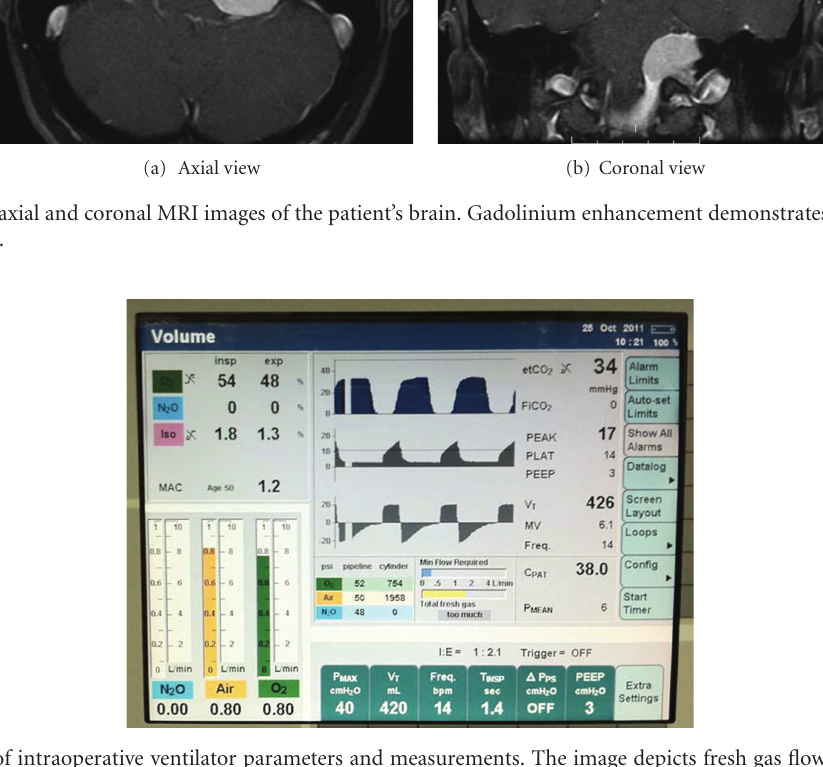
Figure 2: Screen shot of intraoperative ventilator parameters and measurements. The image depicts fresh gas flows, expired and inspired concentrations of isoflurane, airway pressures and flows, and expired CO 2 tracings. Tidal volume was set at approximately 6mL/kg. The anesthesia machine was an Apollo from Dr¨aeger (Pittsburgh,